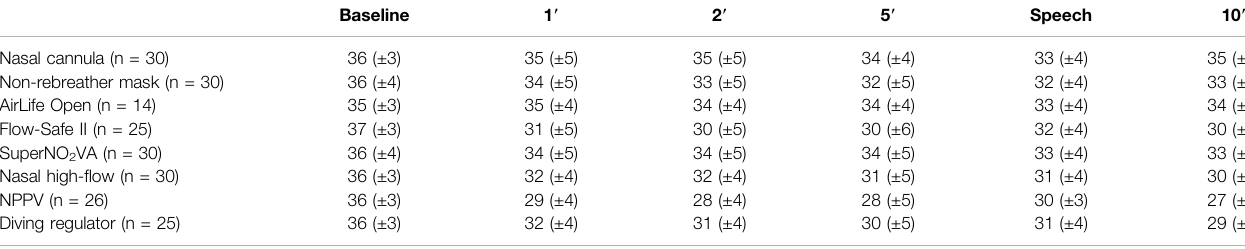
TABLE 2 | Mean arterial pCO2 (mm Hg) during breathing with the different oxygen systems (mean and standard deviation).